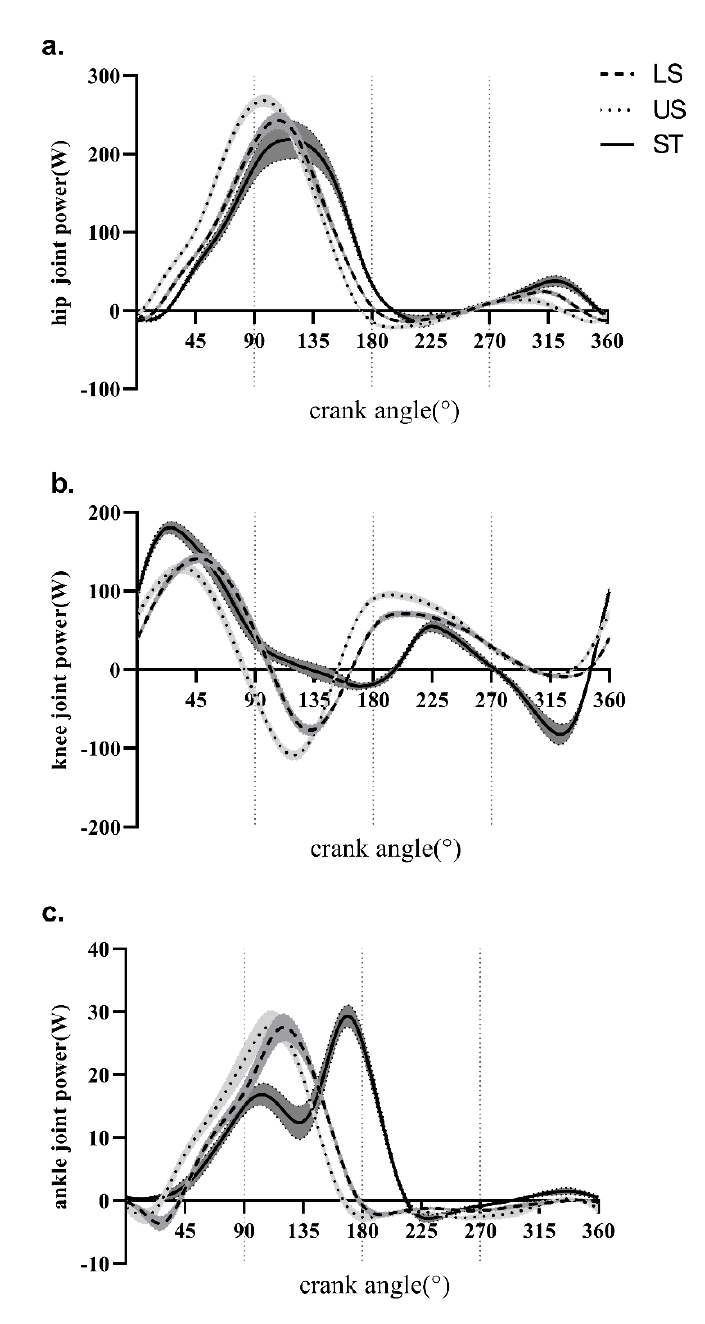
Figure 3. Average curves of ( a ) hip, ( b ) knee, and ( c ) ankle joint power ( ± SEM) during cycling in the LS, US and ST conditions at a constant power output. ( a ) hip joint power; ( b ) Knee joint power; ( c ) ankle joint power; The vertical dash line in 90 ◦ , 180 ◦ and 270 ◦ refers to the border between each adjacent phase from P1 to P4.